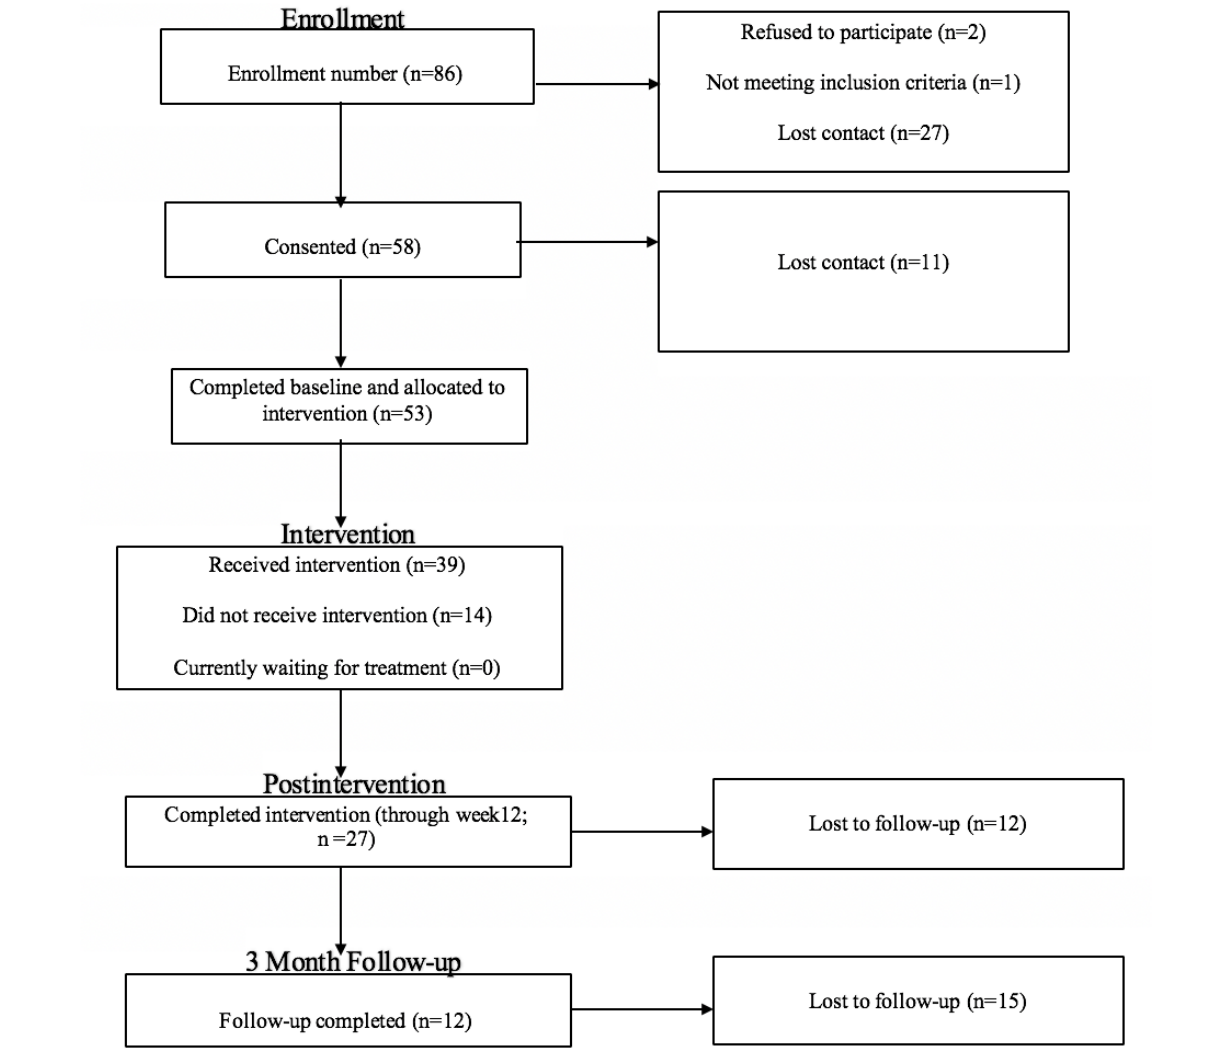
Figure 1. CONSORT